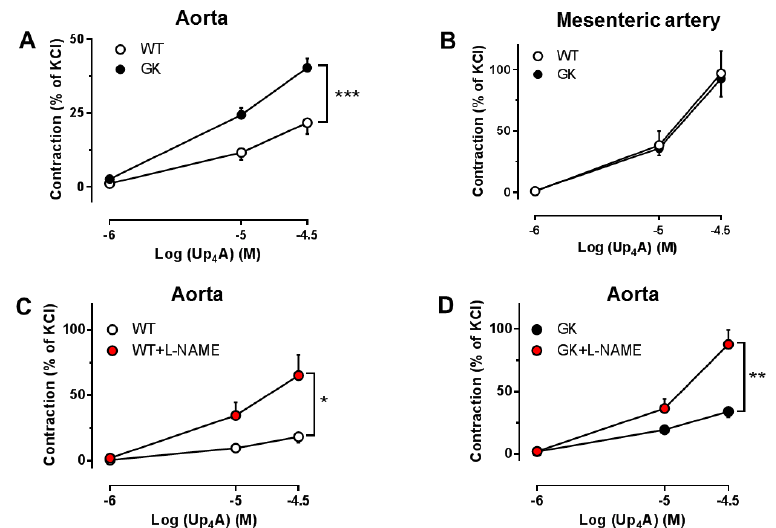
Figure 5. Vasoconstrictor response to Up 4 A at baseline in arteries from WT and GK rats. Comparison of concentration response curves to cumulative application of Up 4 A in aortas ( A , WT n = 18, GK n = 32) or mesenteric arteries ( B , WT n = 7, GK n = 8) between WT and GK rats. Effects of nitric oxide synthase inhibitor L -NAME on Up 4 A-induced contraction in aortas of WT and GK rats ( C , WT n = 5; D , GK n = 9). Data are presented as mean ± SEM as percentage contraction of KCl. * p < 0.05; ** p < 0.01; *** p < 0.001, calculated with two-way ANOVA.